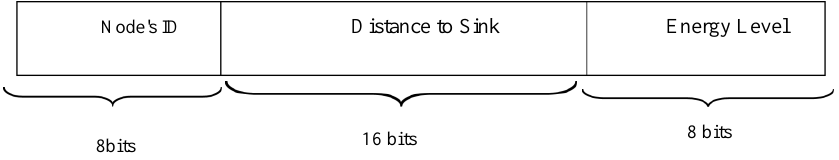
Figure 2. Structure of response (echo)